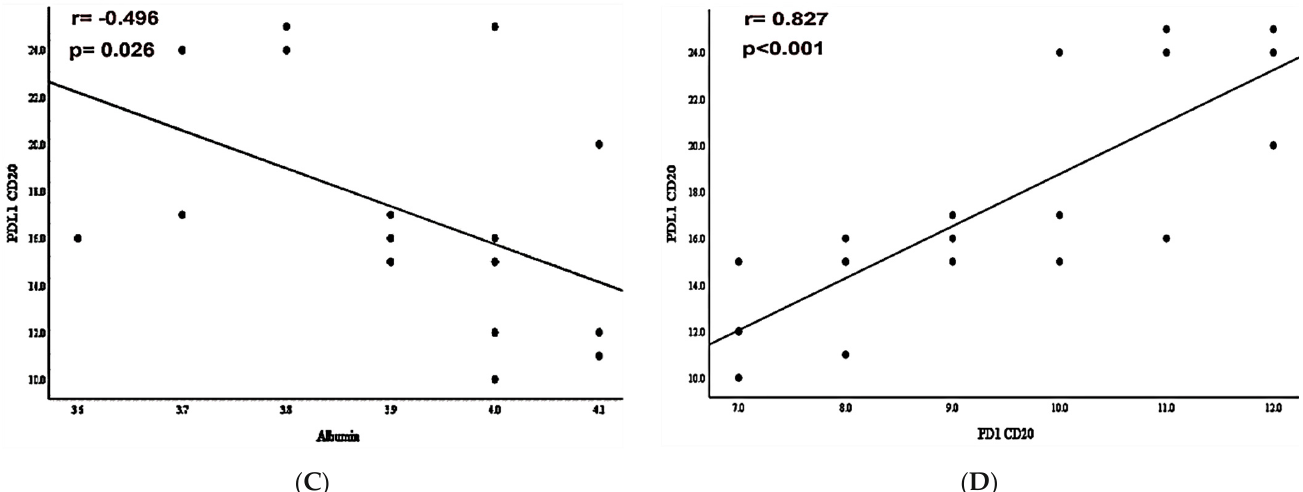
Figure 2. ( A ) Diagram illustrating the positive association between percentages of CD20+ cells and total bilirubin levels (r = 0.511; p = 0.021); ( B ) diagram illustrating the negative association between percentages of CD20+ cells and serum albumin levels (r = − 0.524; p = 0.018); ( C ) diagram illustrating the negative association between percentages of PD-L1+CD20+ cells and serum albumin levels (r = − 0.496; p < 0.026); ( D ) diagram illustrating the positive correlation between PD-L1+CD20+ % and PD-1+CD20+ % (r = 0.827; p < 0.001). Pearson’s correlation analysis was used. Table 5. Correlation of high CD20+ %, PD-L1+CD20+ %, PD-1+CD20+ % cells and DLBCL patient disease characteristics. High High CD20+ % <0.001 ** Random glucose (P) (mg/dL) 0.019